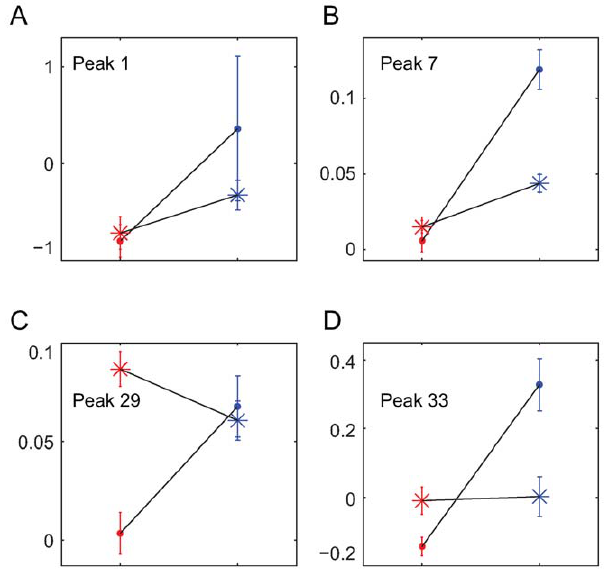
Figure 4. Interactions between tumor type and tumor stage. Normalized intensity (on the vertical axis) of the four peaks (A 2 D) in which a two-way ANOVA indicated significant ( P , 0.002) interactions indicating differentiation between the two tumor models. The horizontal axis of each of the 4 panels (A 2 D) indicates the two stages, early - prior to significant tumor development on the left and later - after development of significant tumor size. Red: tumor, Blue: placebo, Circle: LKR, Star: LLC.